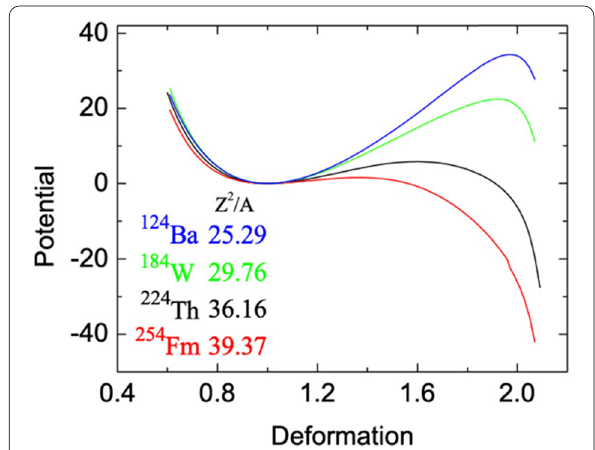
Fig. 1 Liquid drop model potential as a function of deformation for different combinations of A and Z . Values of Z 2 / A are indicated. The deformation of 1 corresponds to the spherical shape. The figure is adapted from